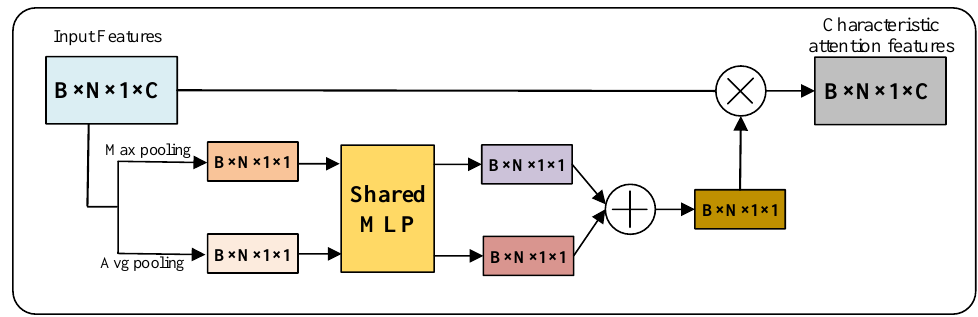
Figure 12. Point cloud feature attention mechanism A c